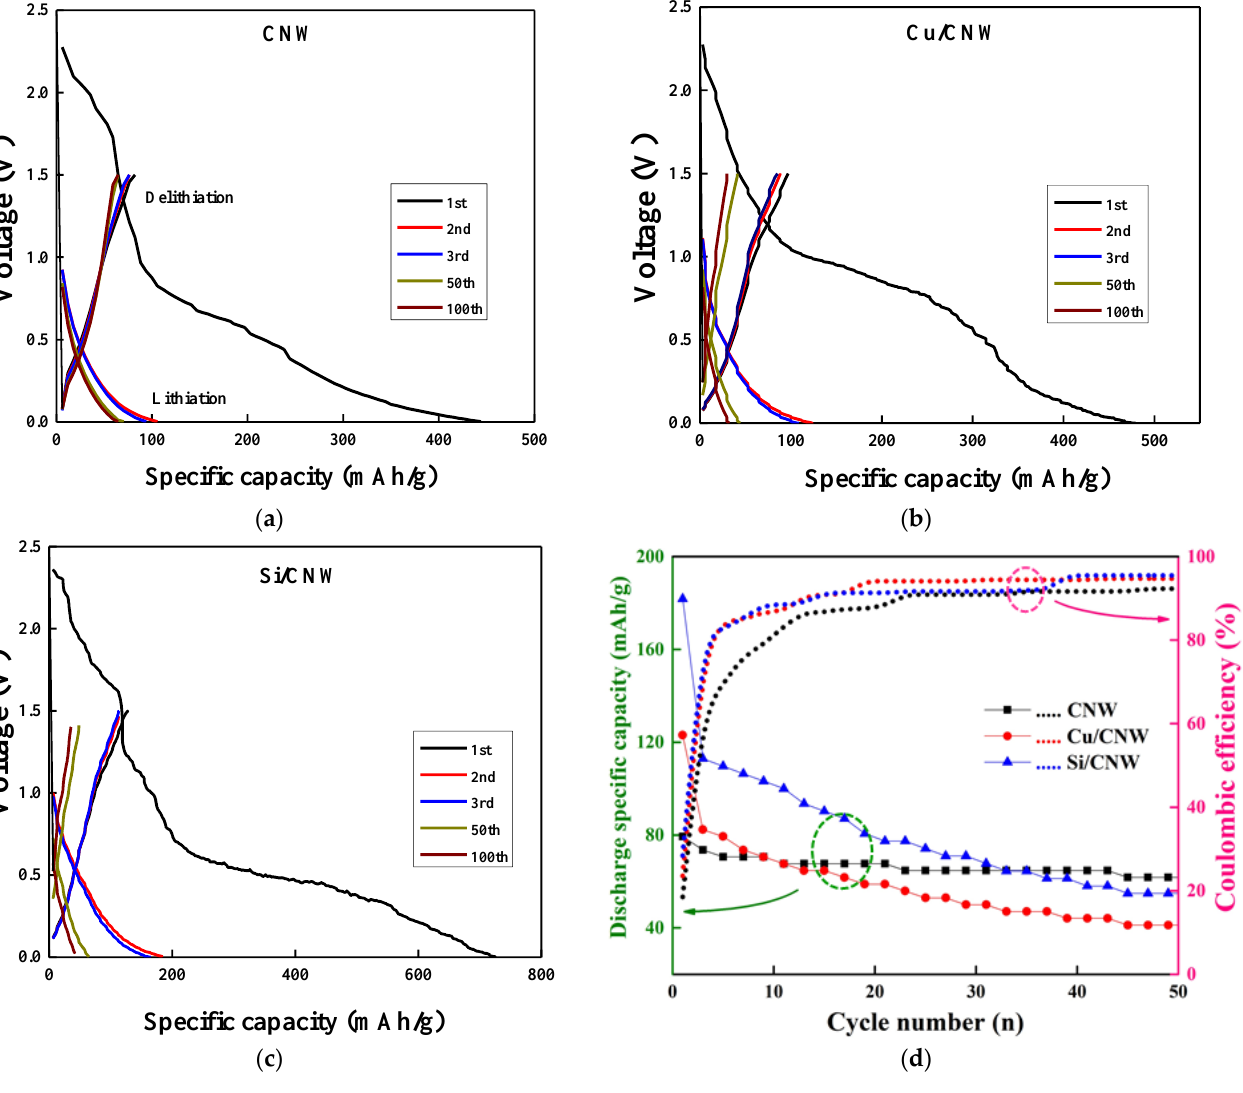
Figure 9. Charging and discharging profiles of LIBs based on CNW ( a ), Cu − CNW ( b ), Si − CNW ( c ), and Cycling performance of LIBs based on CNW, Cu − CNW, and Si − CNW ( d ).